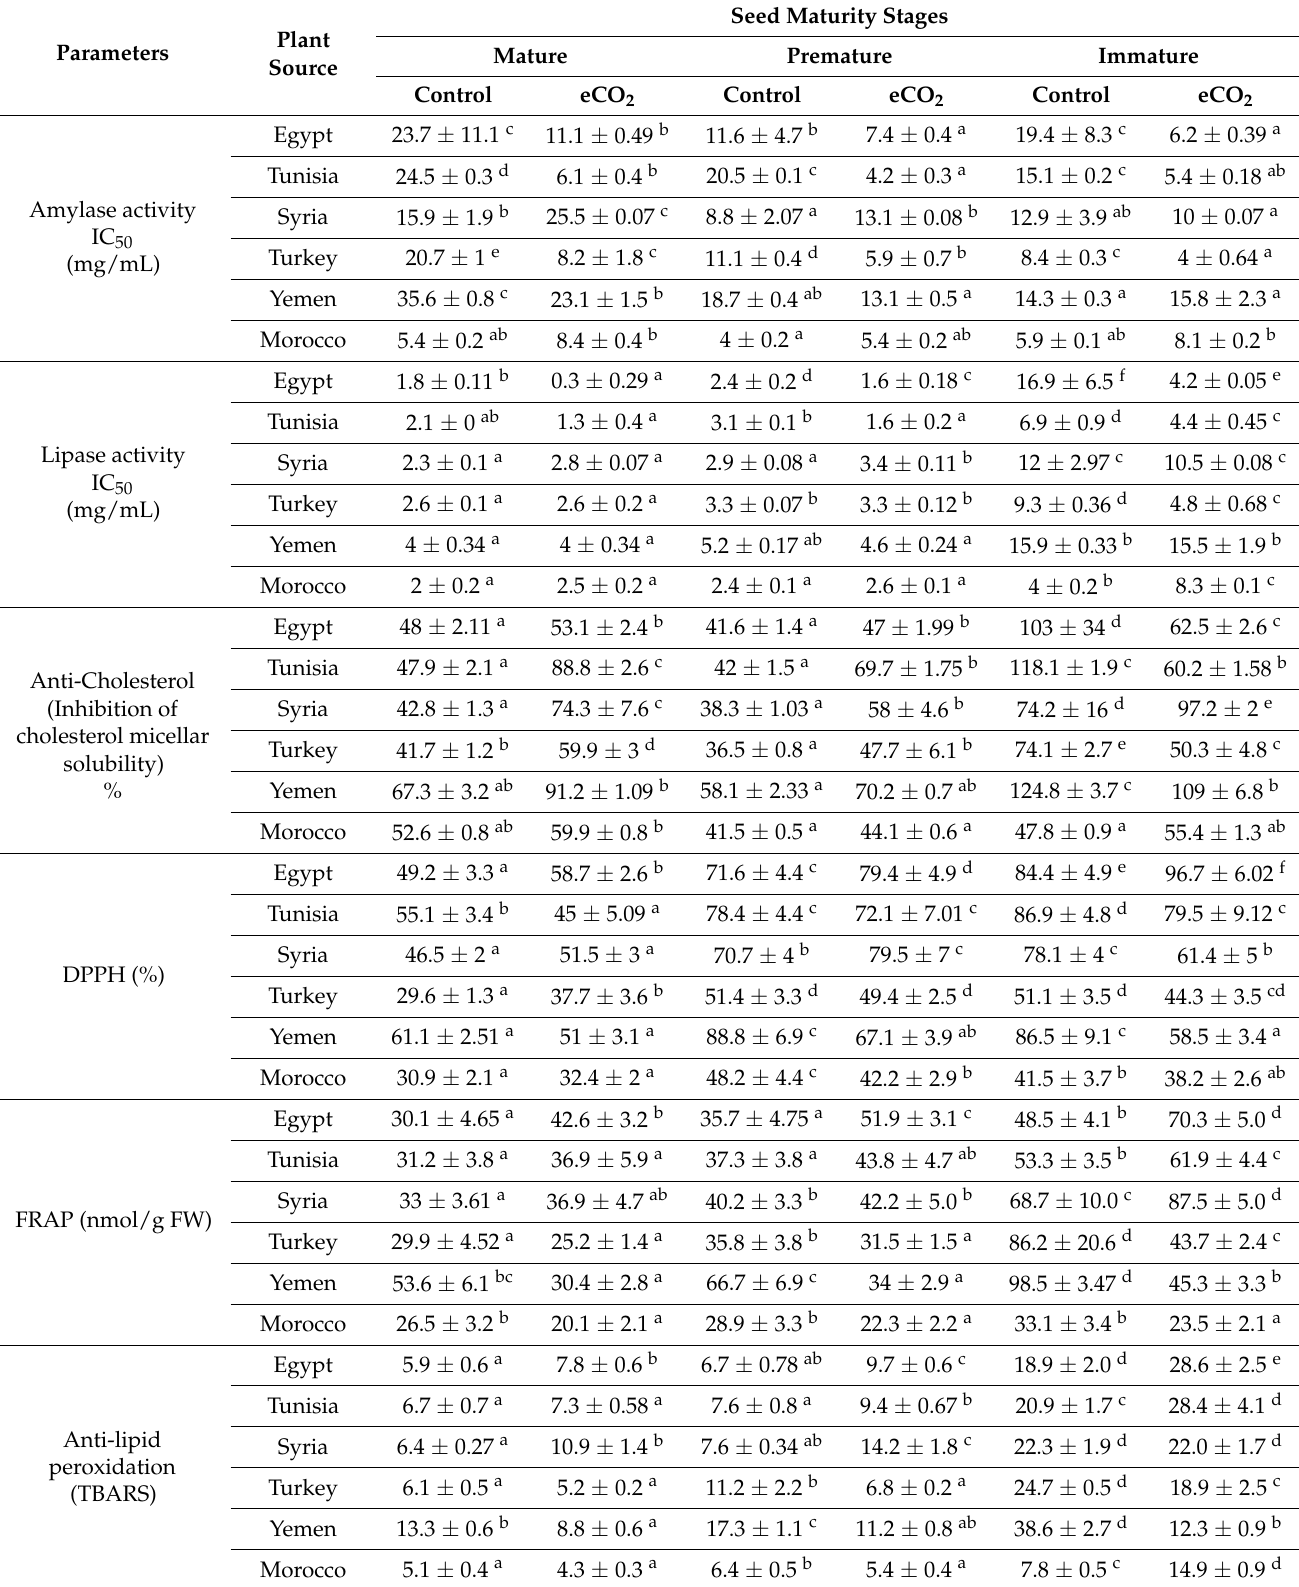
Table 3. Biological activity of six Pimpinella anisum L. accessions at three seed developmental stages and under control and elevated CO 2 (eCO 2 ) growth conditions. Data are represented by the means of at least 5 replicates ± standard error. Different small letter superscripts within a row indicate significant differences between control and eCO 2 -treated samples at p <